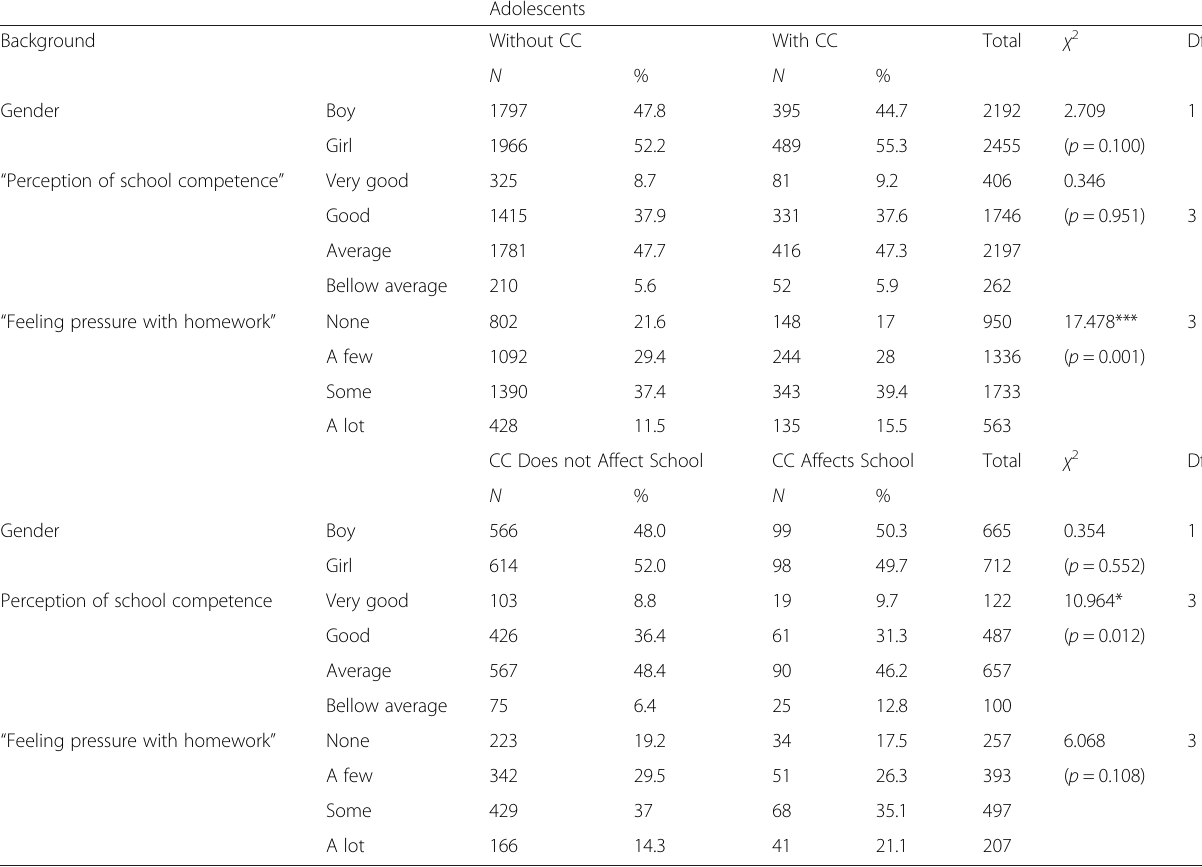
Table 2 Bivariate analysis ( Χ 2 ) of study independent variables and 1) having or not a chronic condition (CC), and 2) CC affecting or not participation/regular attendance in